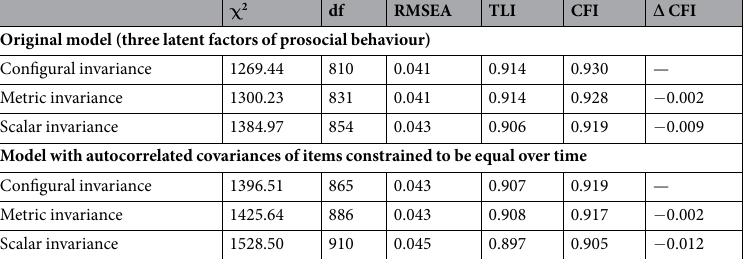
Table 2. Fit indication for the multiple time point confirmatory factor analyses. χ 2 = values of the Likelihood Ratio Test (chi-square); df = degrees of freedom ; RMSEA = Root Mean Square Error of Approximation; TLI = Tucker-Lewis-Index; CFI = Comparative Fit